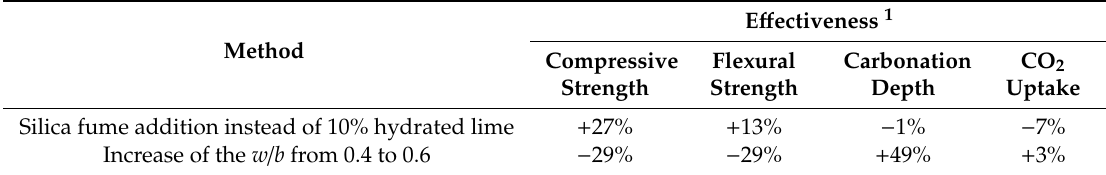
Table 3. Quantitative evaluation of the w / b and silica fume addition on the mechanical properties and CO 2 uptake of air lime mortar at 91 days. E ff ectiveness 1 Method Compressive Flexural Carbonation CO 2 Strength Strength Depth Uptake Silica fume addition instead of 10% hydrated lime + 27% + 13% − 1% − 7% Increase of the w / b from 0.4 to 0.6 − 29% − 29% + 49% + 3% 1 The “ + ” and “ − ” symbols indicate increase and decrease,